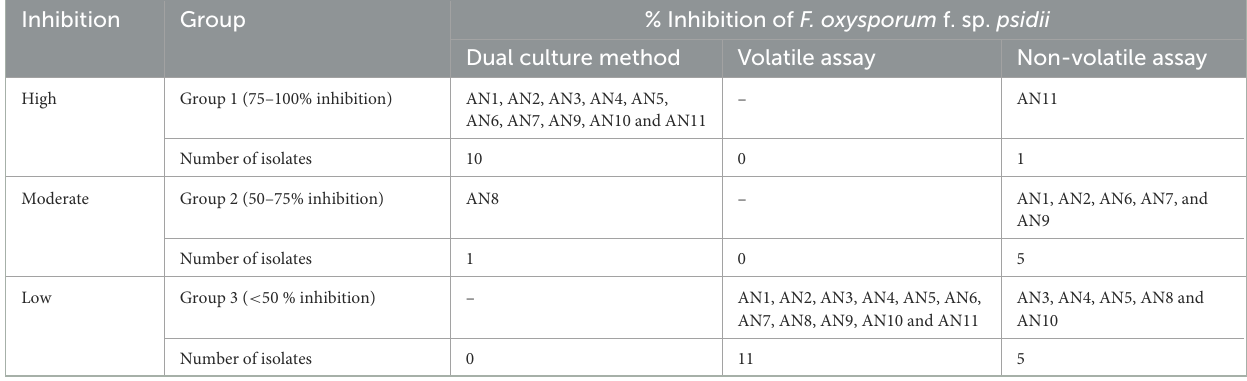
TABLE 3 Grouping of A. niger strains based on percent inhibition of F. oxysporum f. sp. psidii under in vitro conditions.